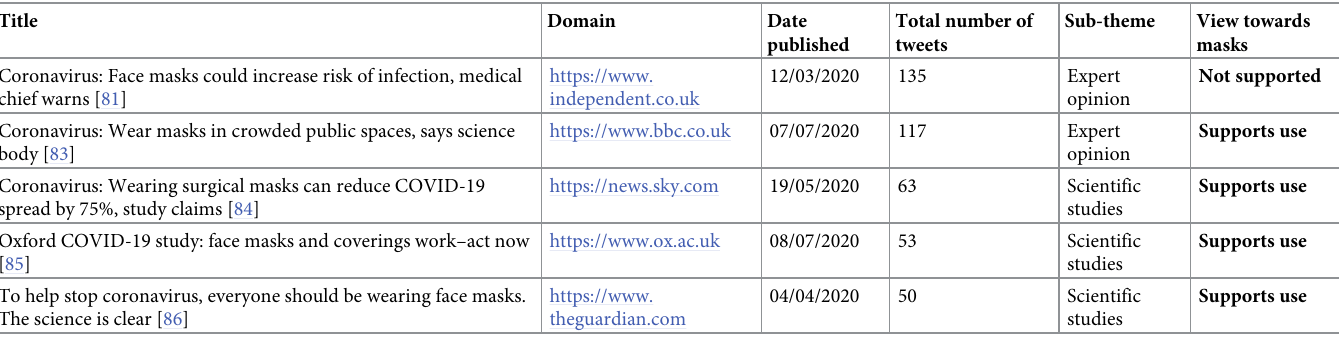
Table 7. URL titles (duplicates combined) contained in most tweets for URLs classified as ‘scientific evidence and expertise’ in ‘most tweeted URLs’